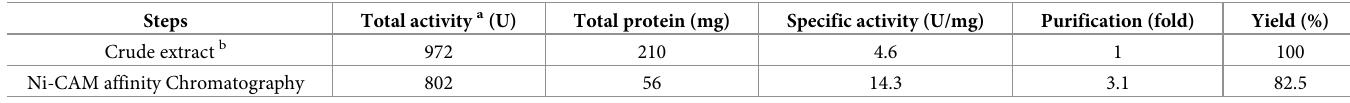
Table 1. Summary of the purification procedure for the recombinant cholesterol oxidase.